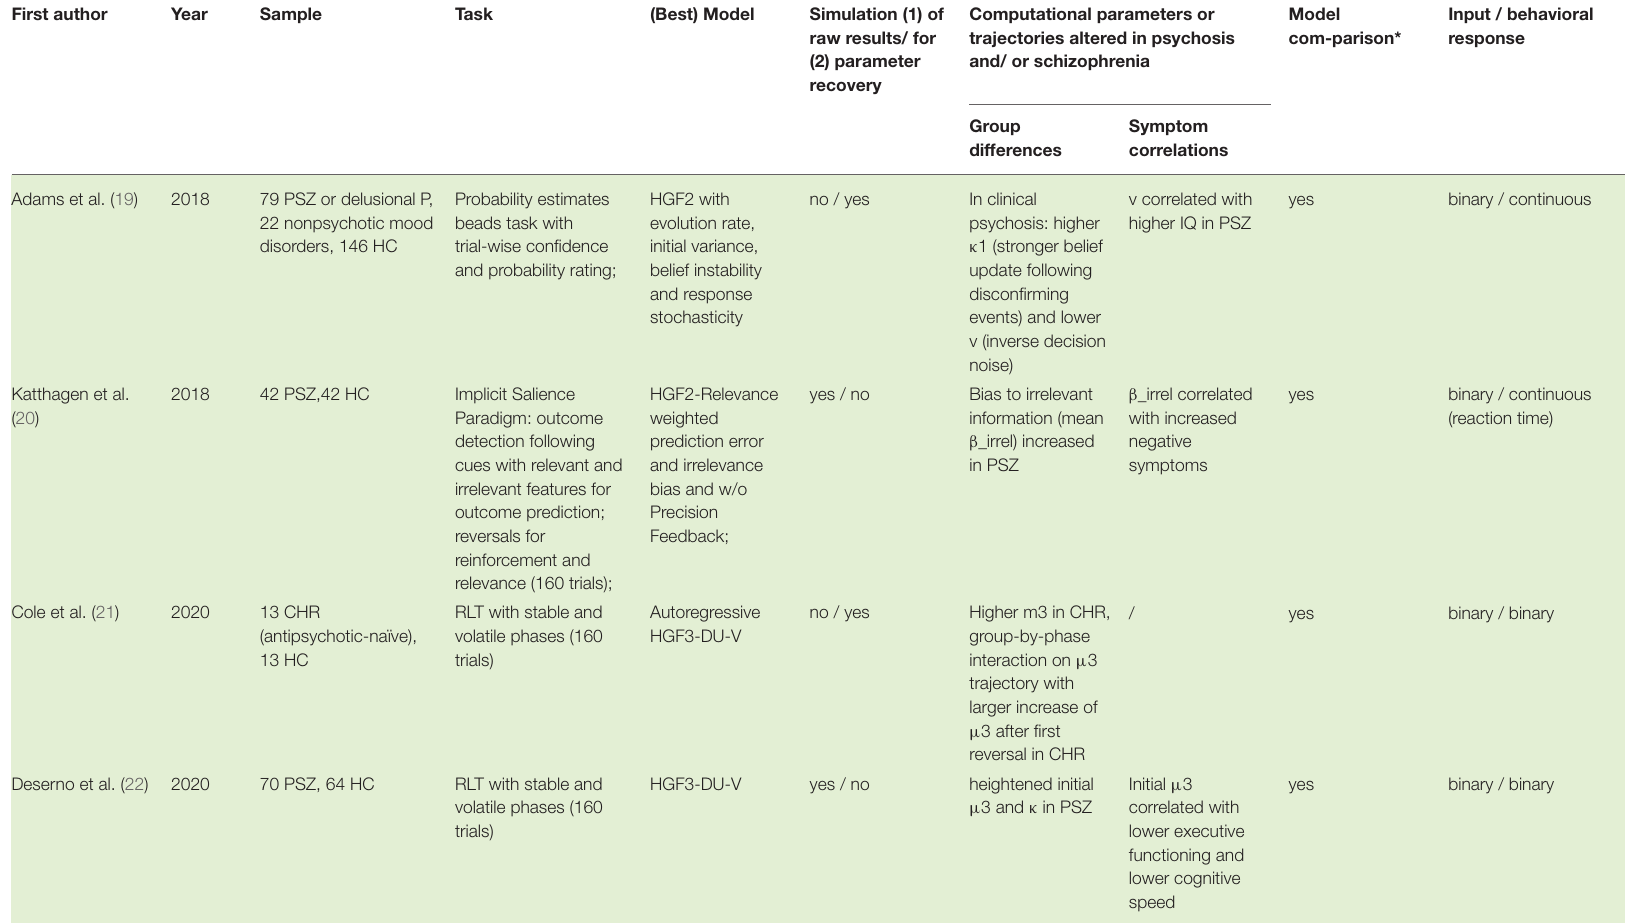
TABLE 1 | Overview of the selected studies with their respective tasks and modeling